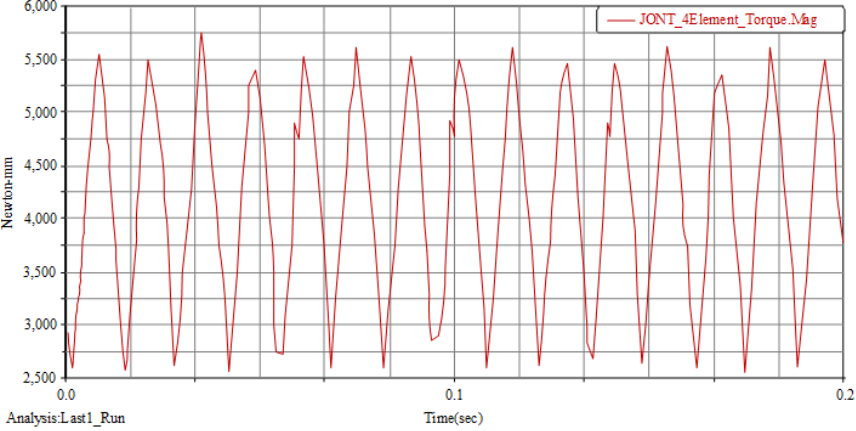
Figure 10. Comparison of spindle torque after stator optimization.